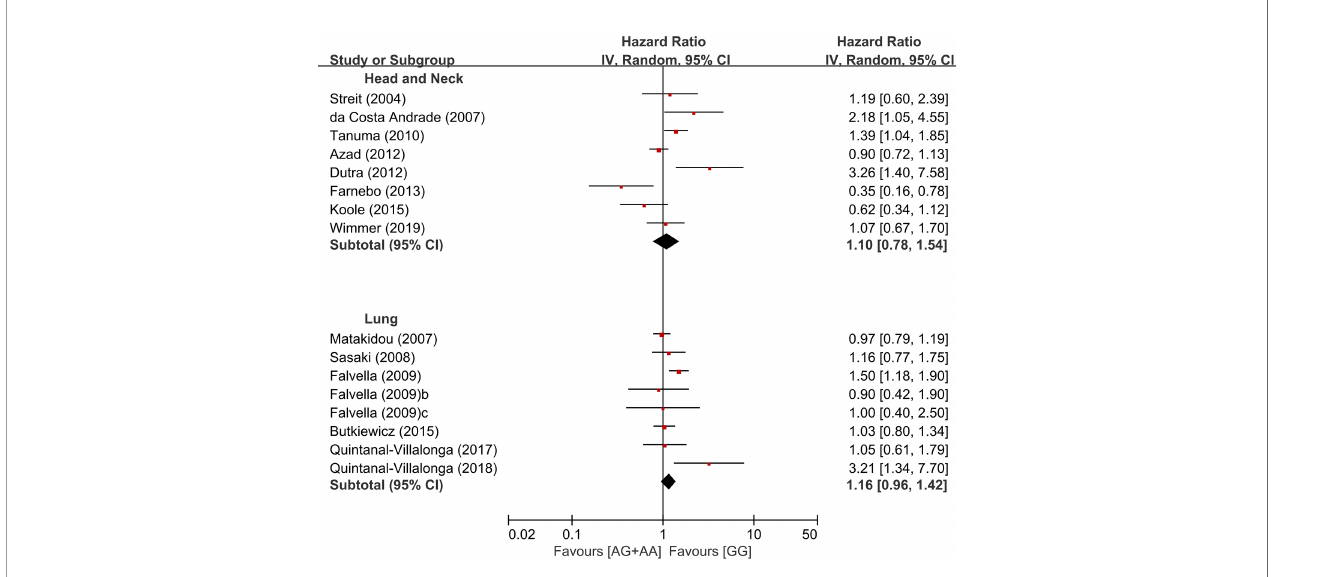
FIGURE 4 | Subgroup analysis according to the primary site.